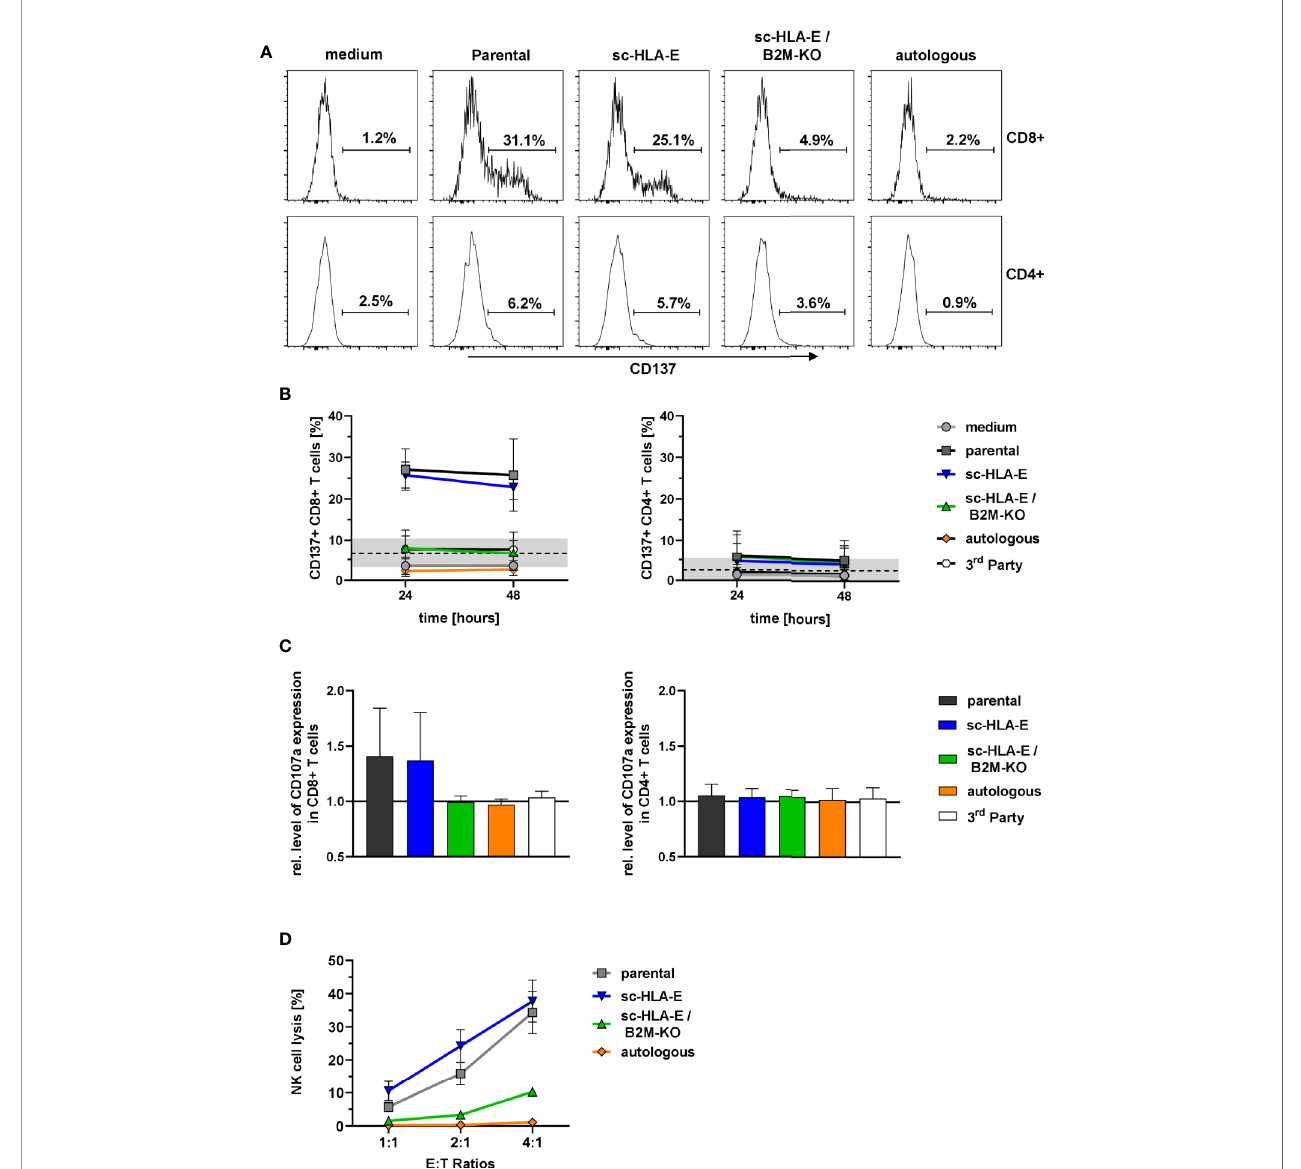
FIGURE 5 | Activation and degranulation of primed T cells in presence of modi fi ed NK cells. (A) Representative fl ow plots showing the frequency of CD137 + cells within CD8 + (upper panel) and CD4 + (lower panel) T cell subsets after 24 h of co-incubation with the different NK cell cultures depicted above the plots. (B) Quanti fi cation of CD137 + frequencies among CD8 + (left) and CD4 + (right) T cells at two time points. Statistical analysis was performed by two-way ANOVA with matching by time points and Holm-Sidak testing. At both time points, the frequency of CD137 + cells within the CD8 + T cells was signi fi cantly lower when challenged with sc-HLA-E/B2M-KO NK compared to parental and sc-HLA-E NK cell containing cultures (mean ± SD; n = 7 for medium control, parental, sc-HLA-E, sc-HLA-E/ B2M-KO NK cells, n = 4 for autologous and 3 rd party controls; black line and grey box indicate the mean of the baseline measurements ± 95% con fi dence interval). (C) Levels of CD107a normalized to the medium controls in CD8 + (left) and CD4 + (right) T cells 24 h after co-incubation with NK cells. Statistical analysis was performed using Friedman test with Dunn ’ s correction for multiple comparisons. Levels of CD107a were signi fi cantly lower for CD8 + T cells incubated with sc-HLA-E/ B2M-KO NK cells compared to T cells incubated with parental or sc-HLA-E NK cells (mean ± SD; n = 7 for medium control, parental, sc-HLA-E, sc-HLA-E/B2M-KO NK cells, n = 4 for autologous and 3 rd party controls). (D) Lysis of NK cells by primed T cells at the effector targets ratios 4:1, 2:1 and 1:1 (calculated on CD8 + T cells) after 20 h of co-incubation. Statistical analysis was performed by two-way ANOVA with Holm-Sidak testing for multiple comparisons. The reduced lysis of sc- HLA-E/B2M-KO NK cells was statistically signi fi cant at E:T ratio 4:1 compared to parental and sc-HLA-E NK cells and at ratio 1:1 compared to sc-HLA-E NK cells but not to parental NK cells, yet the p value almost met the criterion with p = 0.0516 (mean ± SD; n =